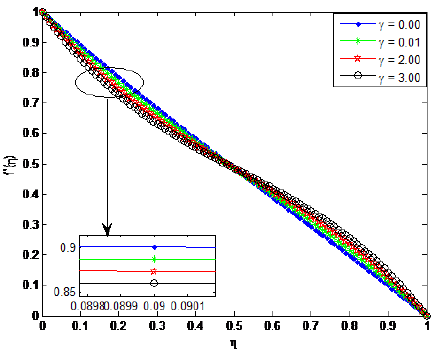
Figure 9. Influence of γ on dimensionless velocity profile